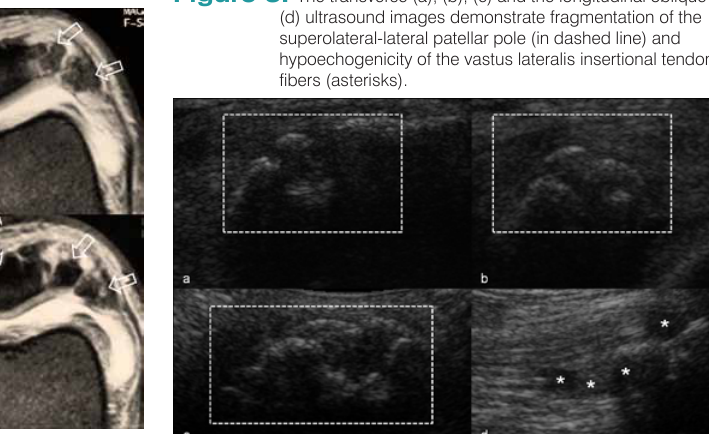
Figure 1. The coronal (a), (b) T1-w and the axial (b), (d) fat suppressed PD-w magnetic resonance (MR) images dem- onstrate the presence of a tripartite patella (open arrows). Note associated bone marrow edema, reactive prepatellar soft tissue edema and the presence of high signal across the synchondroses. Knee effusion is marked with asterisks.